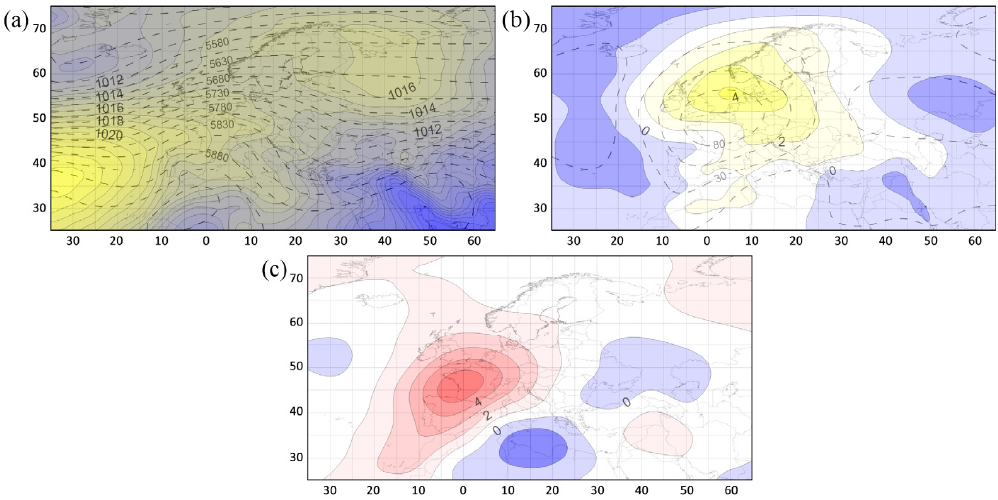
Figure 6. Composites of SLP in hPa (colour scale) and z500 hPa in gpm (dashed lines) ( a ); anomalies of SLP in hPa (colour scale) and z500 hPa in m (dashed lines) ( b ); anomalies of T850 in °C ( c ) for the HW days.